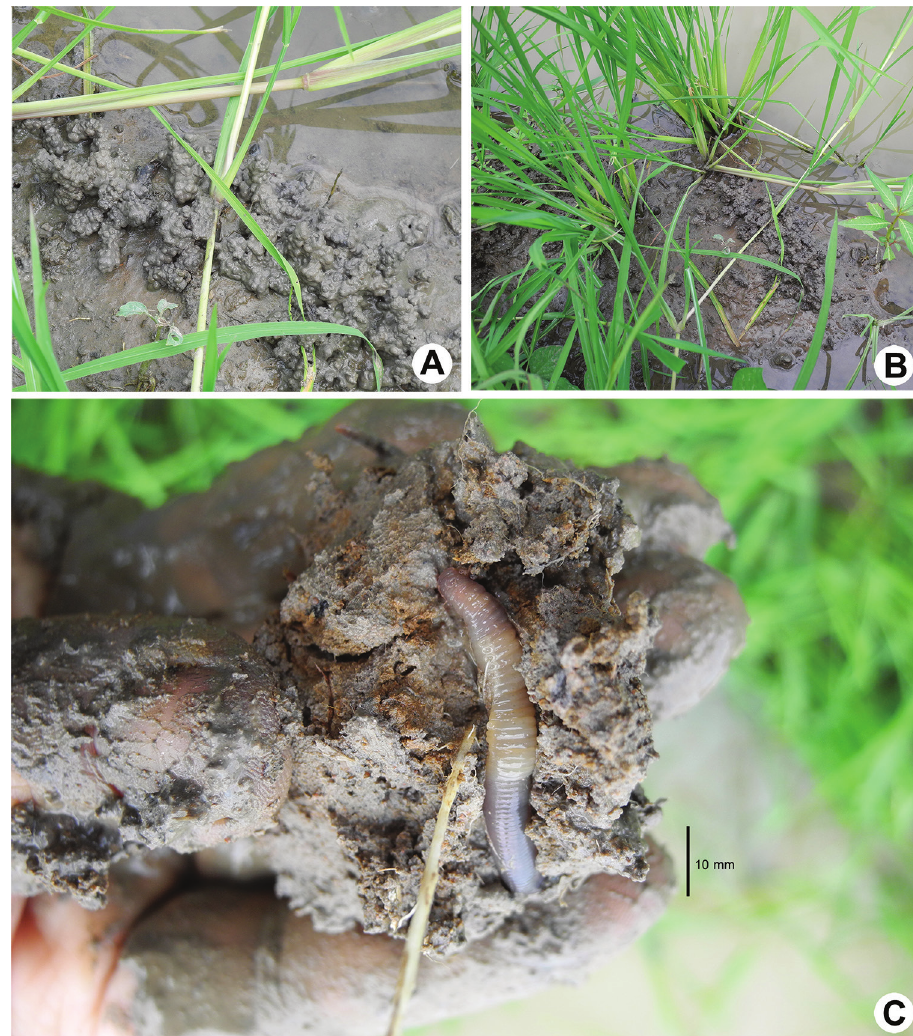
Figure 3. Photographs showing the A Glyphidrilus nanensis sp. n. casts B type locality of G. nanensis sp. n. in the rice field near Nan River at Saklek, Phichit, north Thailand C coloration of living paratype (CUMZ